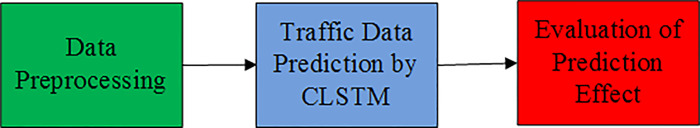
Data prediction based on CLSTM.